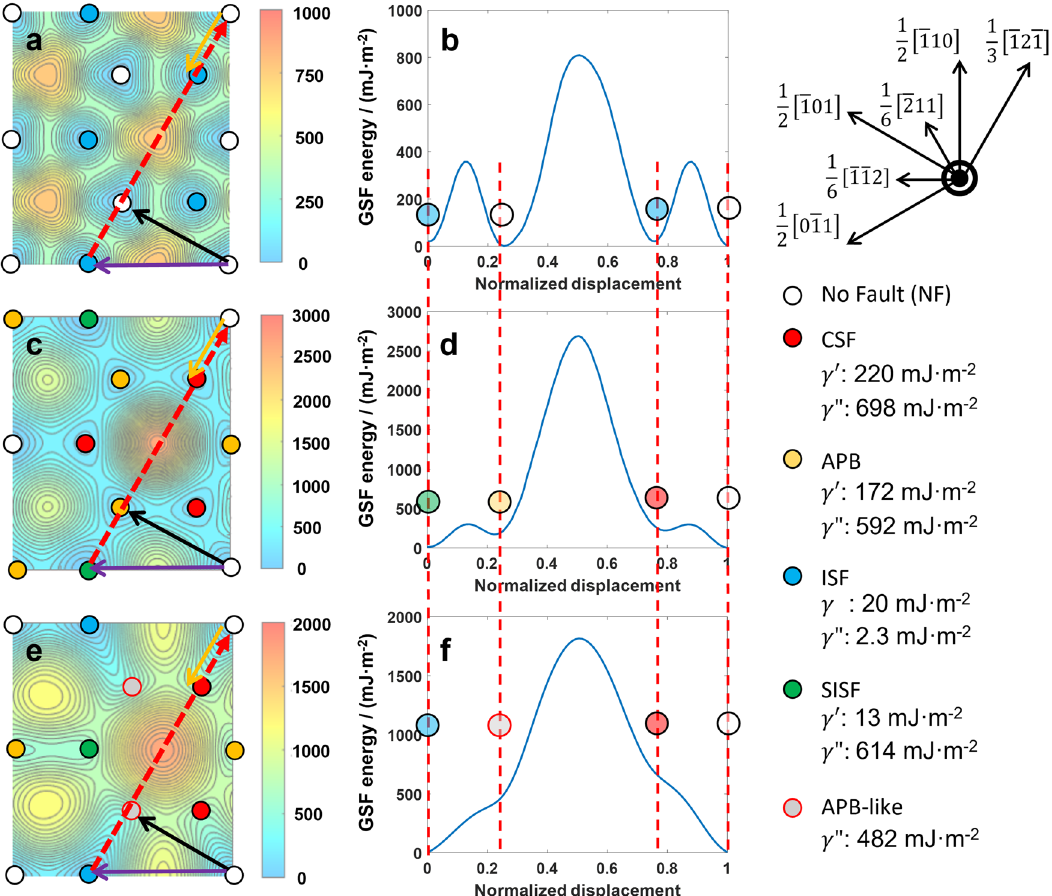
Fig. 1 GSF analysis of γ , γ ′ and γ " phases. GSF surface of {111} plane of a γ , c γ ʹ , and e γ " phases and the energy landscape along the (cid:1) (cid:3) 121 direction of b γ , d γ ′ , and f γ " phases. The no fault (NF) structure is the stacking-fault-free structure in all three phases. The legends for GSF contour plots in ( a , c , e ) have units of mJ m − 2 . The same unit is applied to all GSF contour